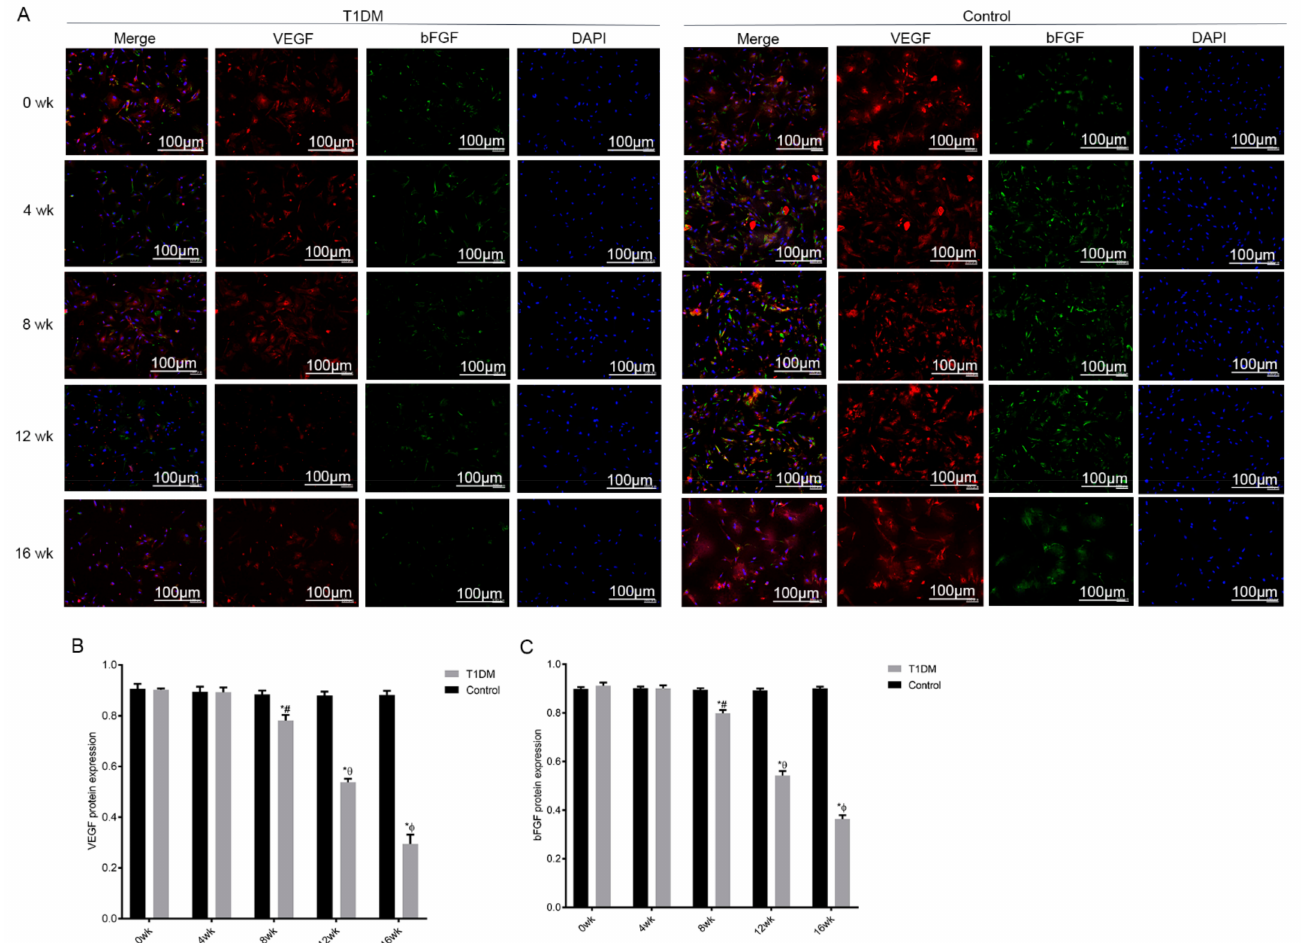
Figure 6. The protein expression and co-localization of VEGF and bFGF in ADSCs. ( A ): Immunofluorescence showed that the protein expression of VEGF and bFGF in ASCs was mainly concentrated in the cytoplasm, and that they were co-located in ASCs. Magnification = 200 × . ( B , C ): The protein expression of VEGF and bFGF was downregulated at 8, 12, and 16 weeks in the T1DM group compared with the control group at the same time point. *, p < 0.05. The expression of VEGF and bFGF continued to downregulate with the prolongation of the course of diabetes. #, p < 0.05, vs. 4 weeks of T1DM. θ , p < 0.05, vs.